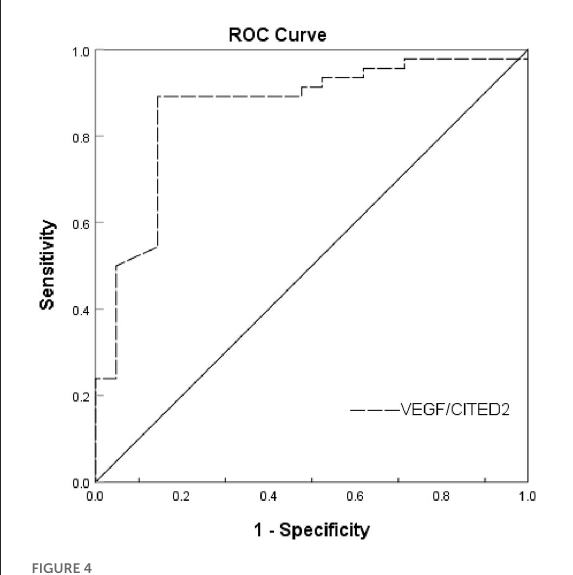
FIGURE4 ROC curve analysis of the VEGF/CITED2 in the collateral circulation of